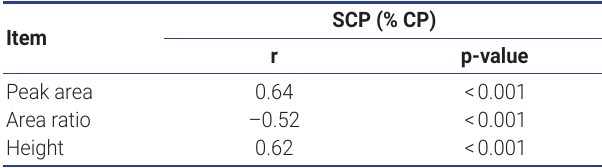
Table 12. Correlation study between FTIR protein structures and the protein portions of the CNCPS system profile of canola meals Item